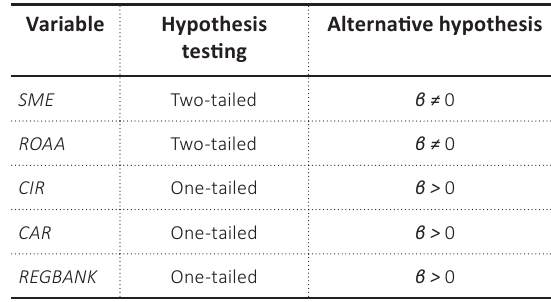
Table 1. Summary of hypothesis and testing